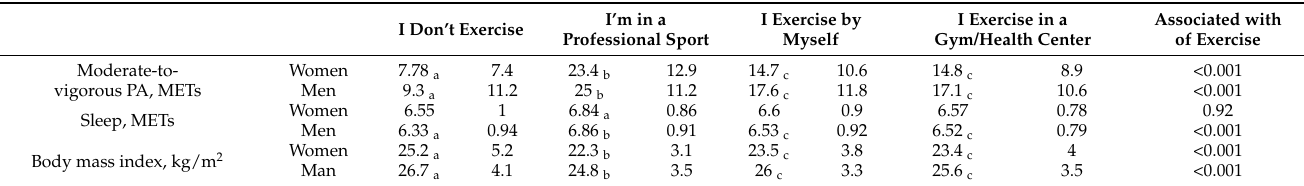
Table 2. Moderate-to-vigorous physical activity, sleep, body mass index, emotional intelligence, and logical thinking in women and